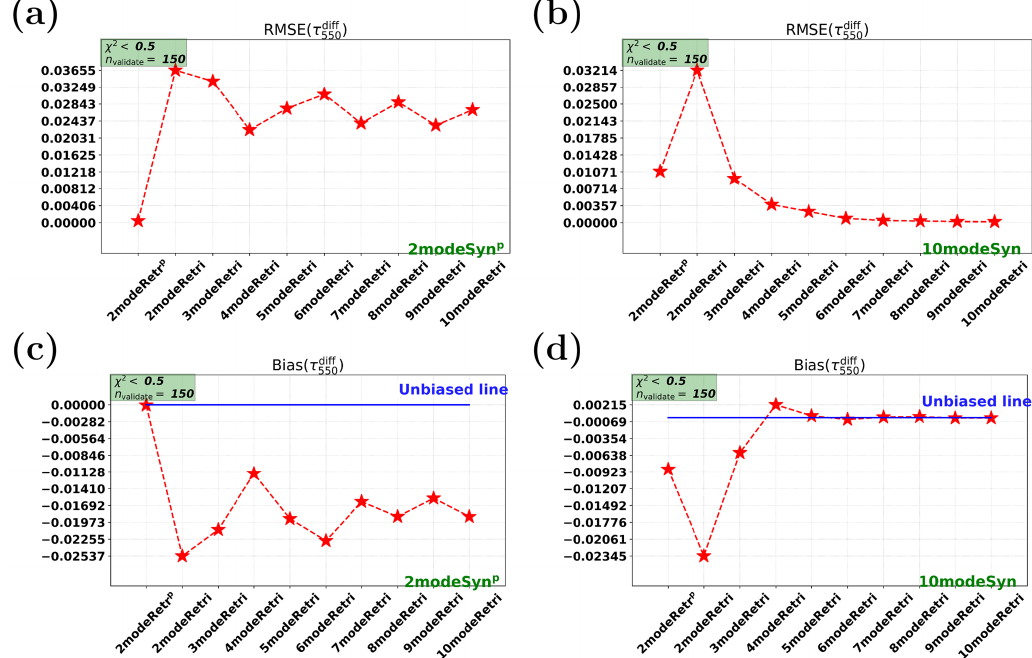
Figure 2. Synthetic retrievals for AOT: root-mean-square error (RMSE) and bias for the difference between the retrieved AOT and the true AOT. The x axis in each subplot represents 2modeRetr p and different multimode retrieval cases (i.e., 2modeRetr, 3modeRetr, ... , 10modeRetr). Panels (a, c) show RMSE and bias for the cases on 2modeSyn p . Panels (b, d) show RMSE and bias for the cases on